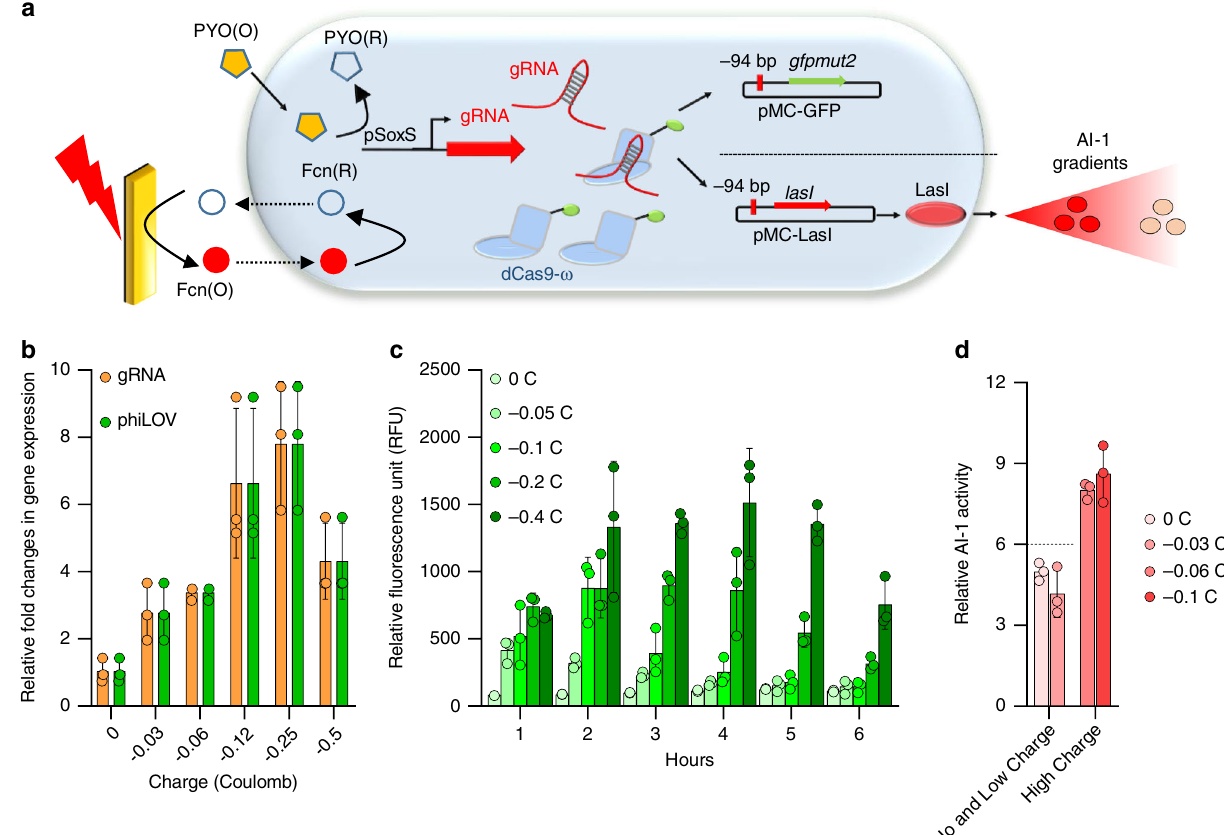
Fig. 3 Electrically tunable CRISPRa — eCRISPR. a Scheme of an electrically controlled CRISPRa system in bacteria with electrical control over gRNA expression from the E. coli pSoxS promoter. NB101 cells containing plasmids pSC-S108gRNA, either pMC-phiLOV or pMC-LasI and pdCas9- ω are grown in aerobic conditions to OD 600 0.6 and later resuspended in minimal-M9 media and moved to an anaerobic chamber for electrical induction. PYO and Fcn(R) is added to cells and an oxidation potential of + 0.5 V is applied to oxidize Fcn(R) to Fcn(O) and turn ON the pSoxS promoter. b qPCR data indicating the relative gRNA and phiLOV expression levels after 2 hours of electrical induction. c CRISPRa mediated phiLOV fl uorescence with varying levels of electrical induction measured via fl ow cytometry. d AI-1 assay indicating the amounts of AI-1 generated via eCRISPRa. AI-1 producer cells are induced with different amounts of electric charges and after 2 h of induction, conditioned media from the AI-1 producer cells is collected and added to the AI-1 reporter cells. After 4 h of incubation with reporter cells, bioluminescence is measured via a luminometer. In all fi gures, independent experimental replicates ( n = 3) are represented by circles. Height of the bars indicate mean and error bars indicate standard deviation. Source data for all fi gures is provided